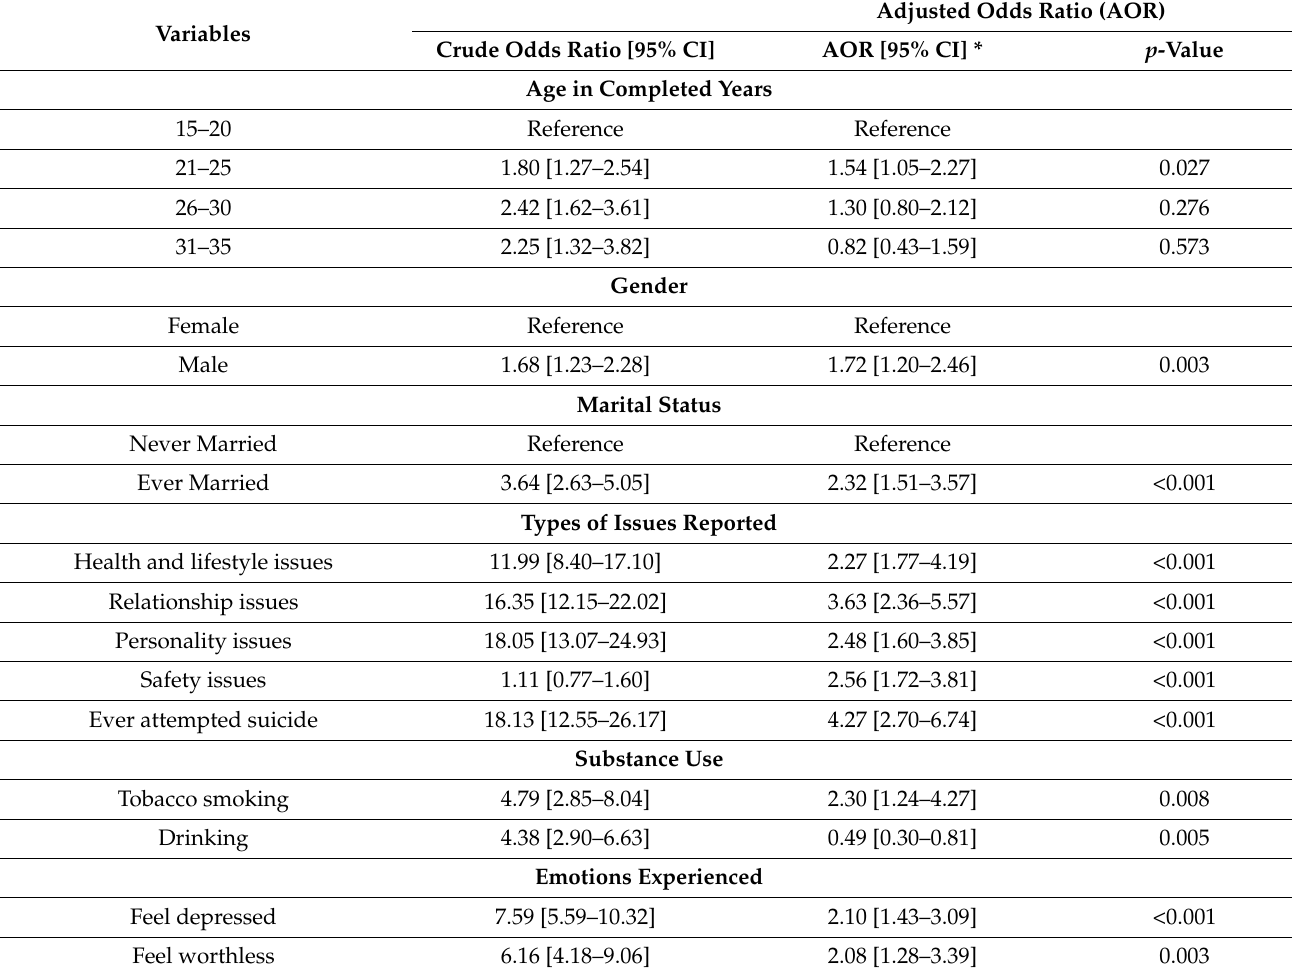
Table 4. Multiple logistic regression analysis for factors associated with gender, sex and sexuality issues among beneficiaries attending youth mental health promotion clinics (2017–2020) in Karnataka. (N =